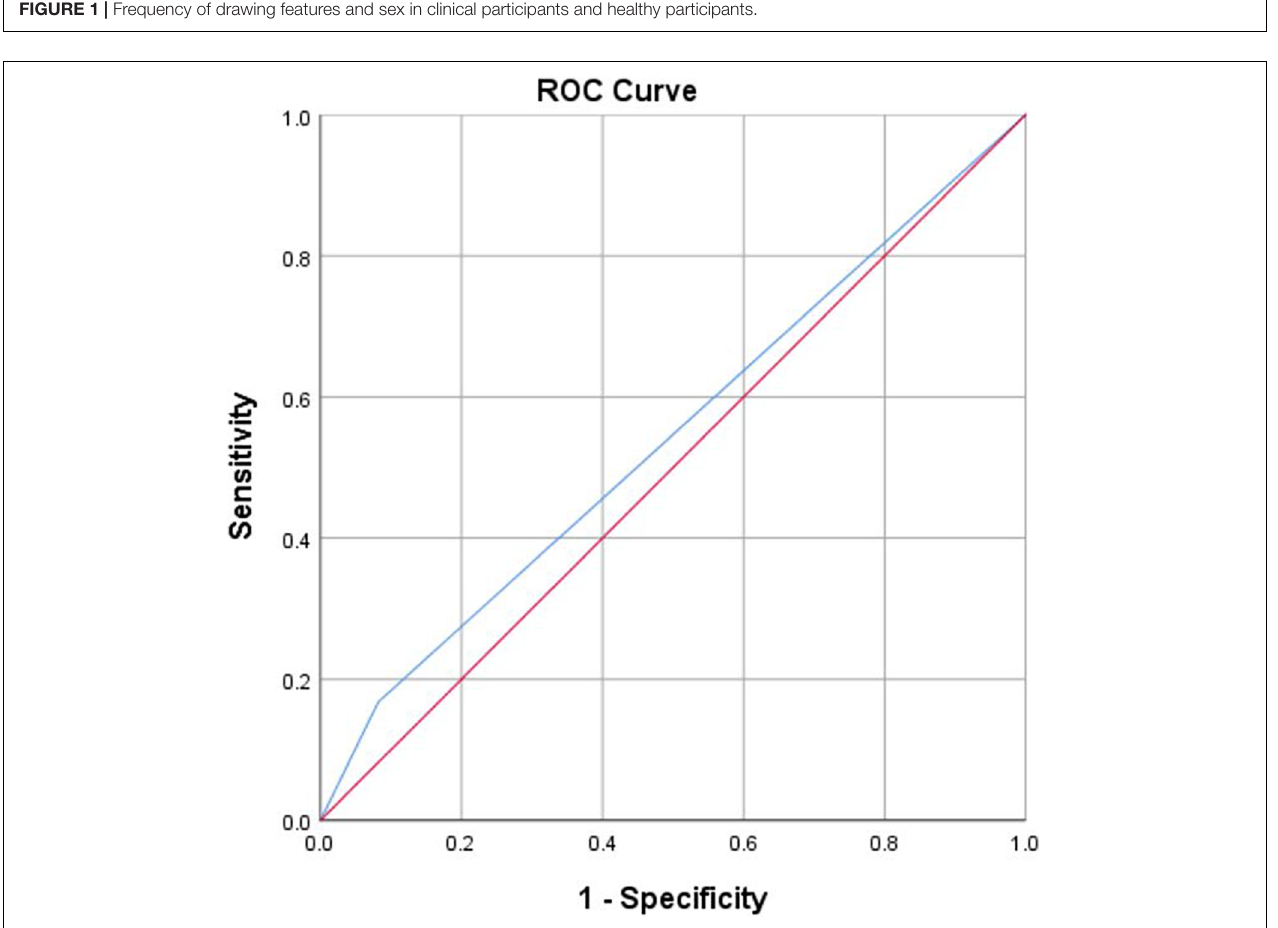
FIGURE 2 | ROC curve of drawing features positively associated with